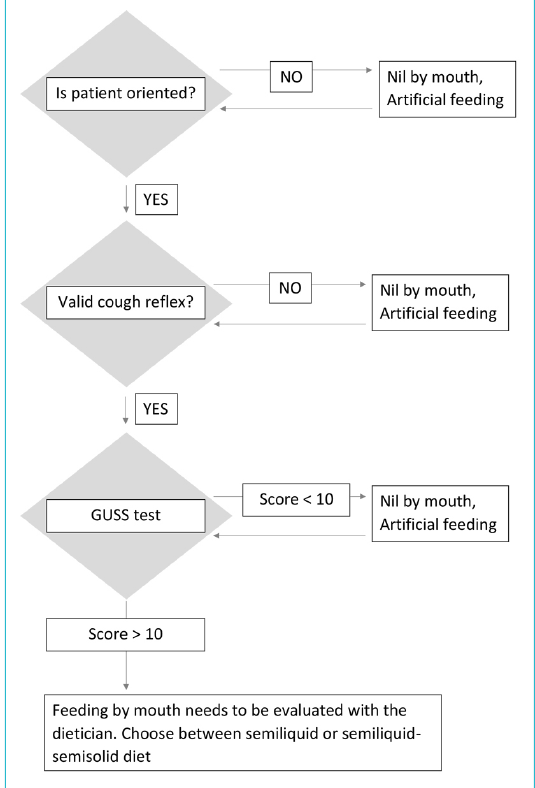
Figure 1: Swallowing screening for “COVID-19 emergency” tra- cheotomy ward.Performers: physician or the respiratory therapist, on demand by the physician.Setting: patient sitting with deflated cuff for at least 30 minutes, all vital signs normal.Safety: mouth hy- giene, aspirator ready to use.Material: semisolid: Nutilis Acquagel: liquid: bottled H 2 0; solid: not tested.(Amitrano, Forni,